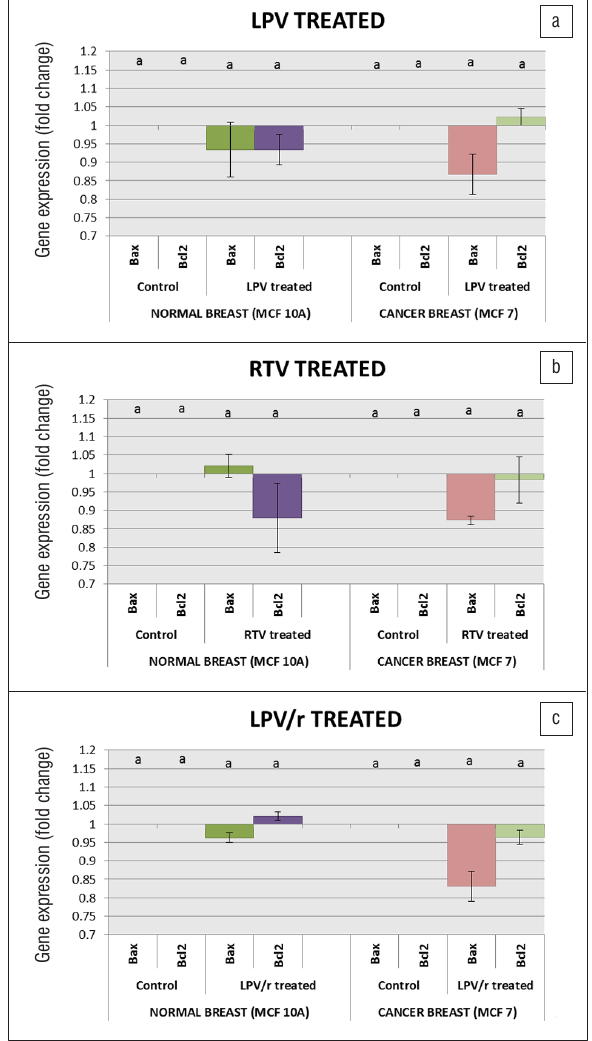
Figure 2: Effects of (a) LPV, (b) RTV and (c) LPV/r on BAX and BCL-2 mRNA expression in normal breast (MCF-10A) and breast cancer (MCF-7) cells. Cells were incubated with 9.8 µg/ mL LPV, 0.6 µg/mL RTV and 9.8 µg/mL LPV/0.6 µg/mL for 96 h. Data (mean±SEM) are represented as fold changes of gene expression relative to values from the vehicle-treated cells (defined as 1) and representative of three independent experiments for RNA extraction. Groups not connected by the same letter are significantly ( p <0.05) different from each